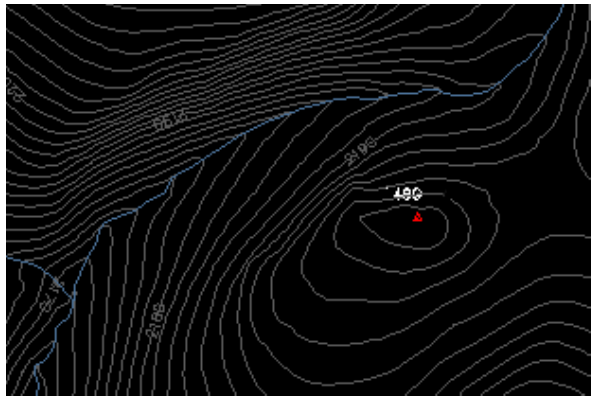
Figure3. 1:5.000 Scaled Topographical Map